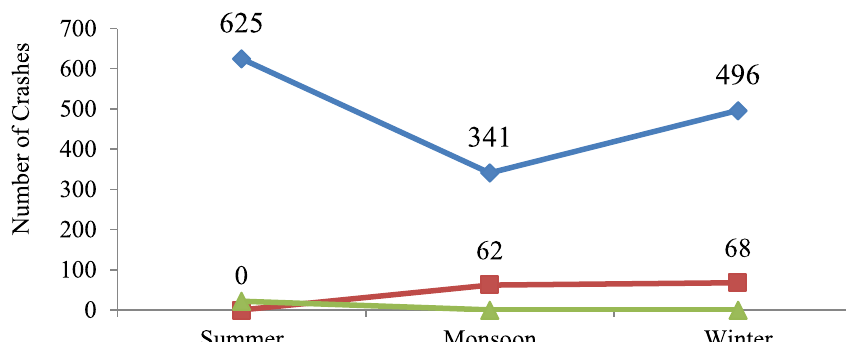
Fig. 10 Season-wise analysis of crash data